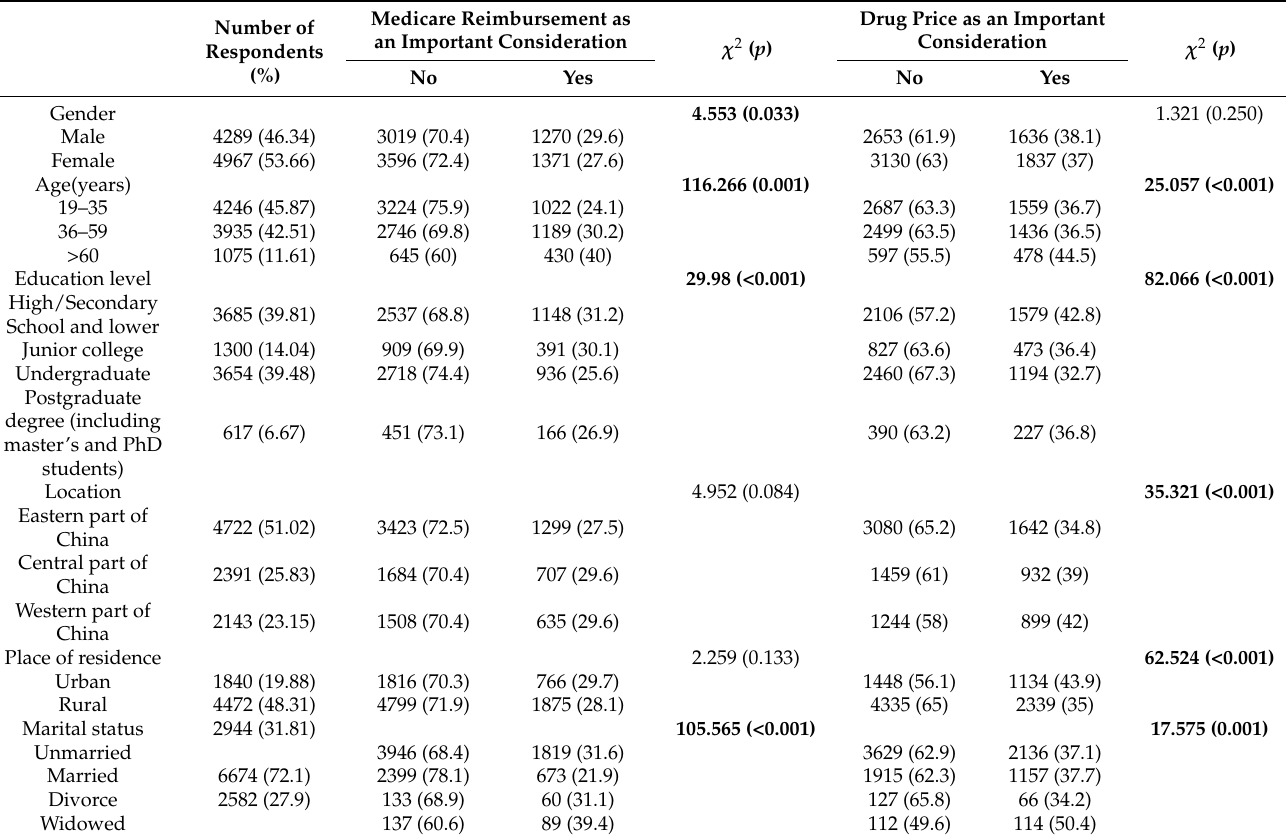
Table 3. Univariate analysis of whether the respondents consider drug Medicare reimbursement or drug price as an important consideration when purchasing